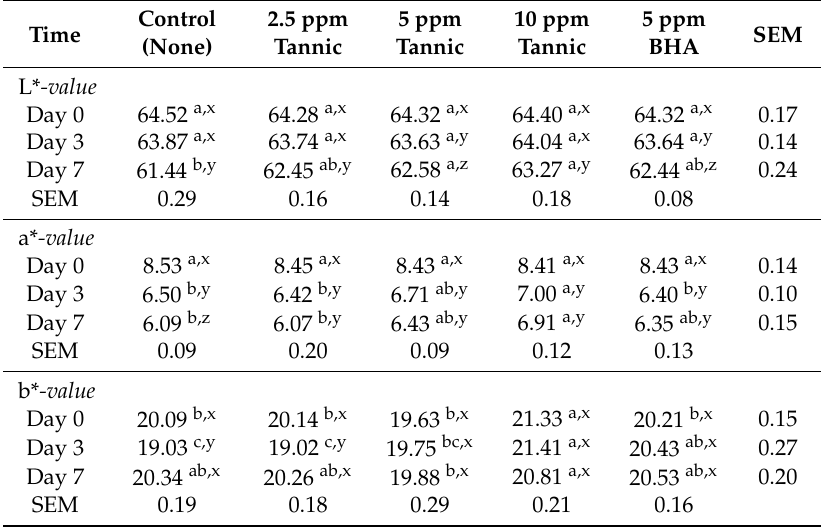
Table 3. CIE color values of raw chicken breast meat with different levels of tannic acid during storage at 4 ˝